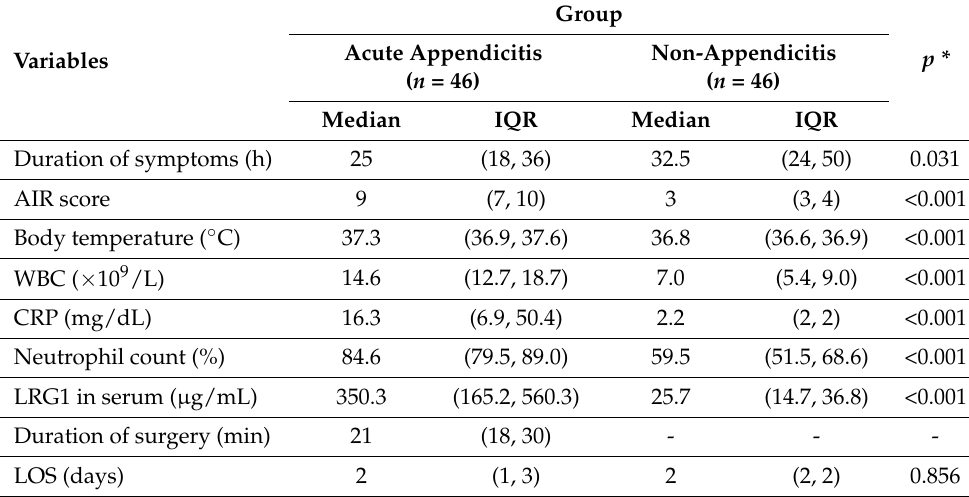
Table 2. Clinical and laboratory data of the